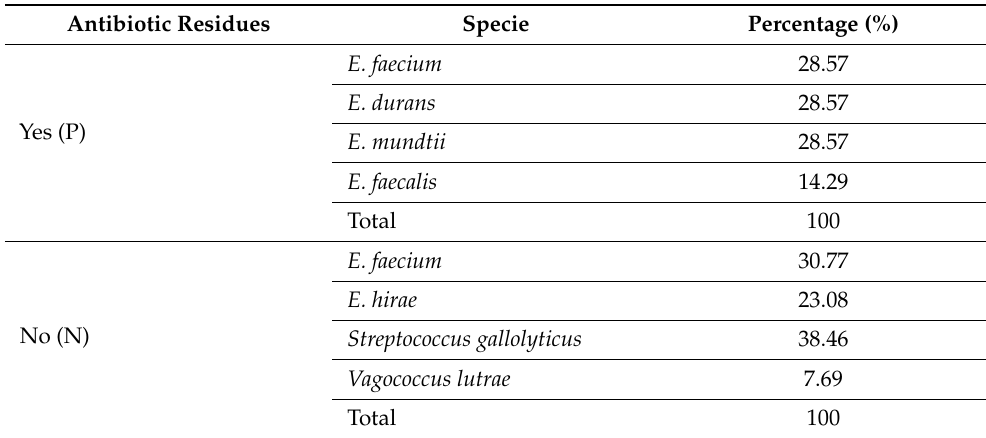
Table 5. Percentage of isolates identified in fresh goat meat from Kanamycin Esculin Azide agar. Samples with the presence of antibiotic residues (P) and free of antibiotic residues